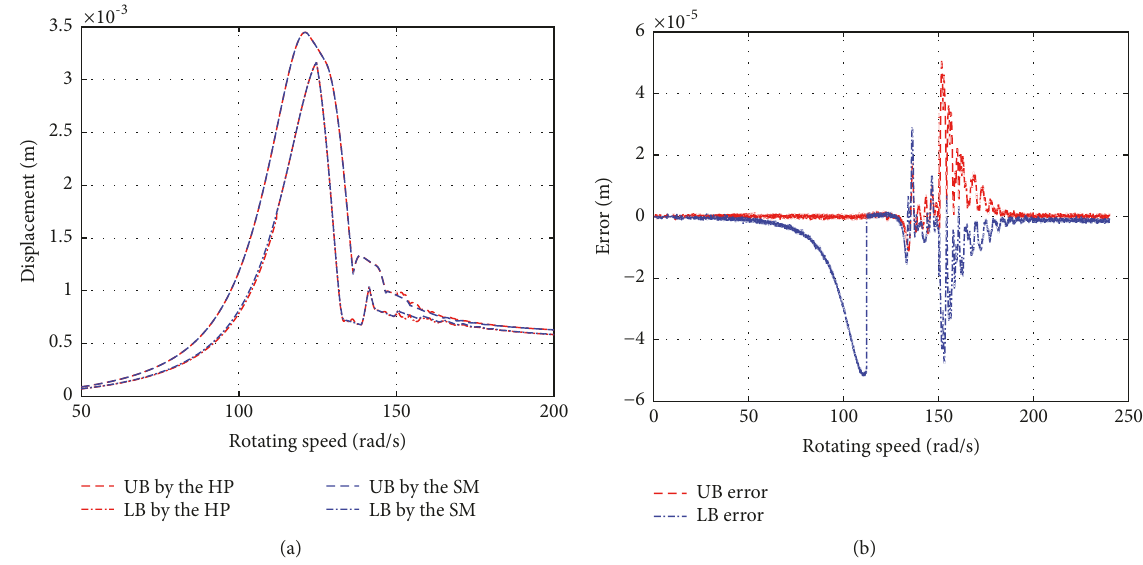
Figure 6: (a) Response ranges with uncertain support stiffness 2 calculated by the hybrid procedure and (b) errors.